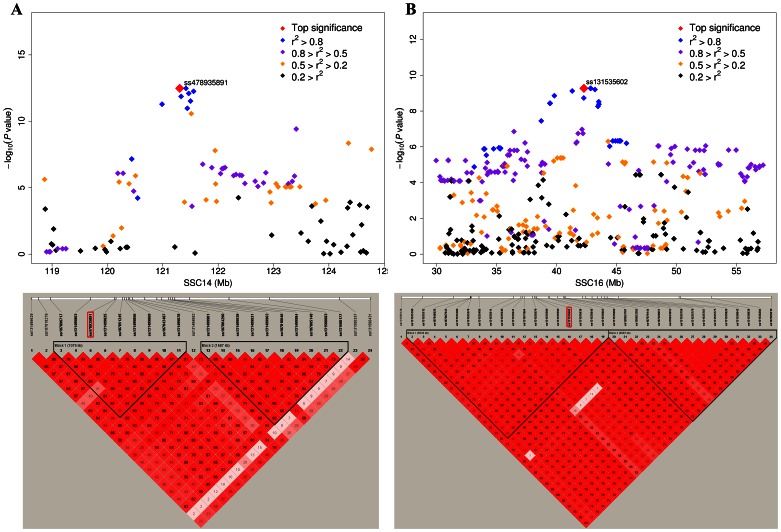
Regional plots of the two major loci on SSC14 and SSC16.Results are shown for muscle C18∶0 on SSC14 (A) and for muscle C20∶0 on SSC16 (B) in Sutai pigs. In the upper panels, the blue diamonds represent the lead SNPs. Different levels of linkage disequilibrium (LD) between the lead SNPs and surrounding SNPs are indicated in different colors. In the lower panels, LD heat maps of SNPs in the two regions are depicted. The top SNPs are highlighted by red rectangles.